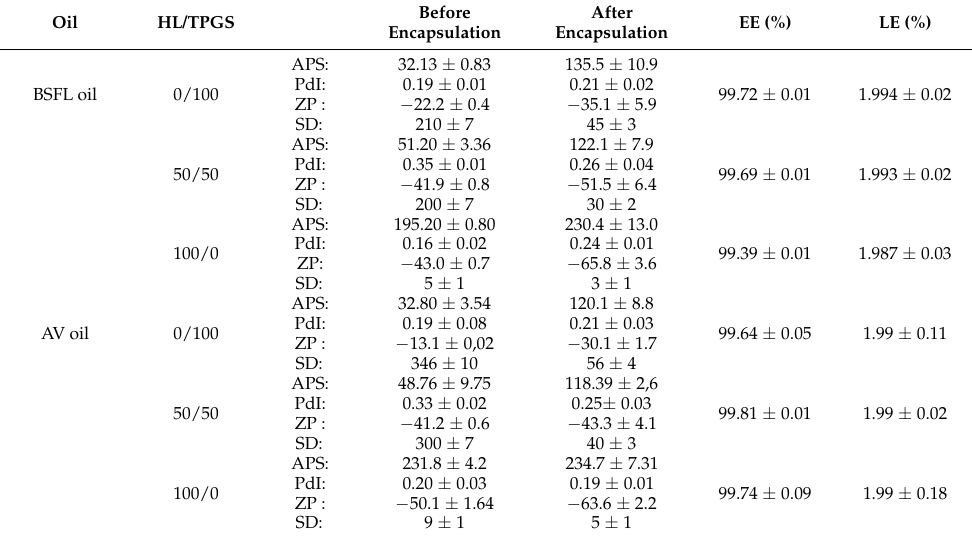
Table 1. Encapsulation efficiency and loading efficiency of BSFL oil NEs and AV oil NEs with SOR 60%, oil content 1% and surfactant ratios of HL/TPGS for Apig with their average particle size (APS) nm, polydispersity (PdI), zeta potential (ZP) mV, and stable days (SD) by comparison before with after